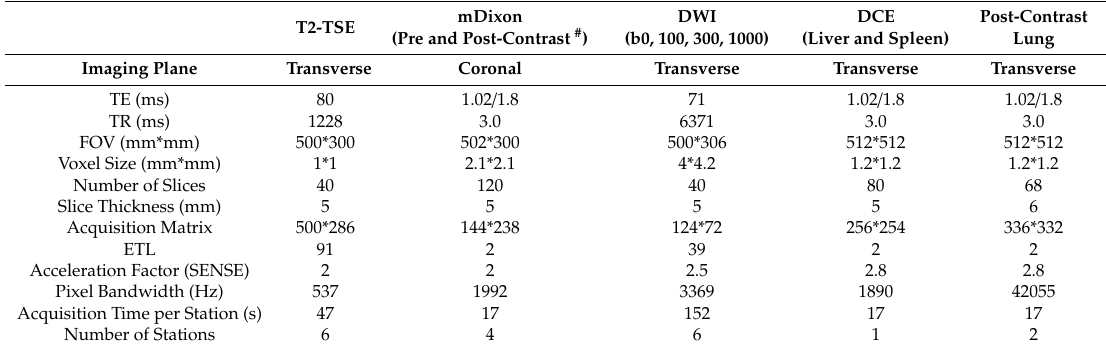
Table 1. Whole-body MRI sequence